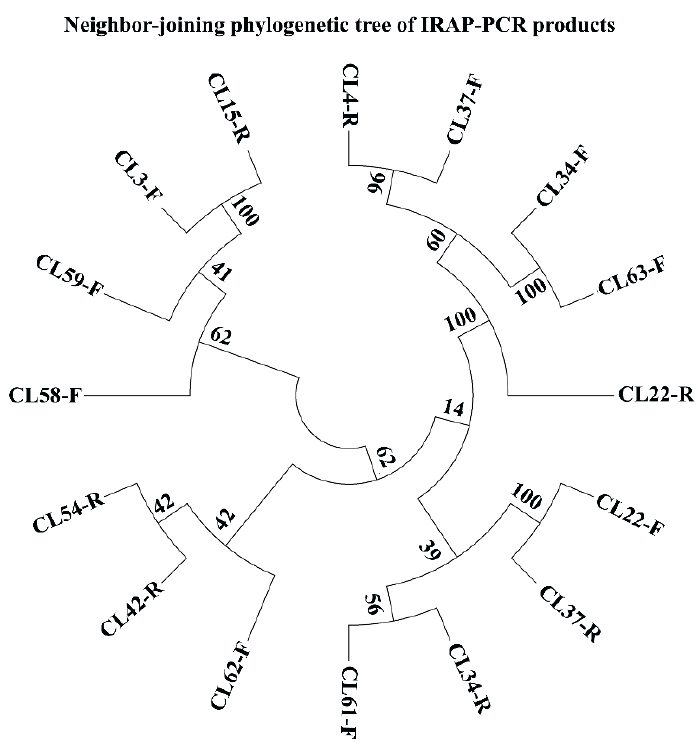
Figure 3. Neighbor-joining phylogenetic tree with bootstrap analysis showing the genetic relationship of 16 inter-retrotransposon amplified polymorphism (IRAP)-PCR amplicon sequences in Phyllostachys species (Asian bamboo) by corresponding IRAP markers.